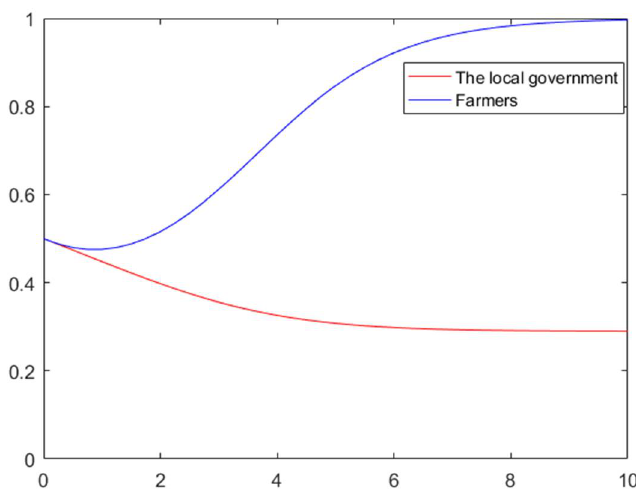
Figure 4. Simulation results under litigation settlement ( C 2 = 1 ) .